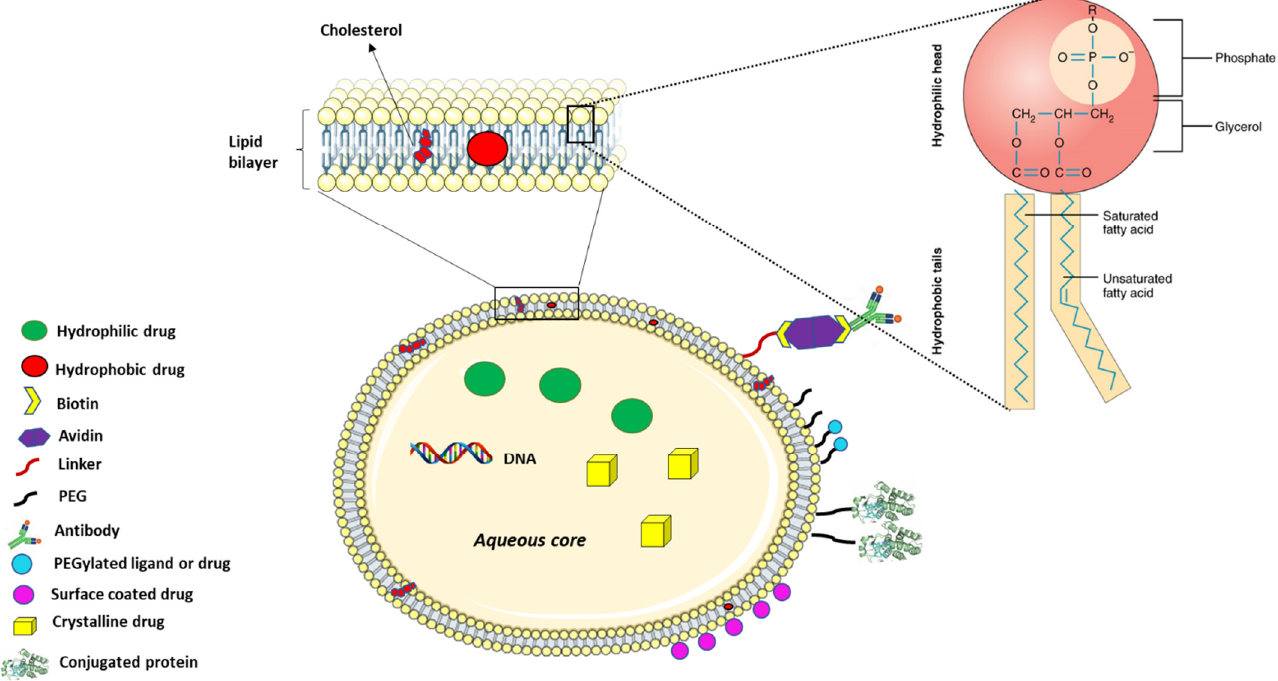
Figure 2. Liposomal modification for drug delivery.